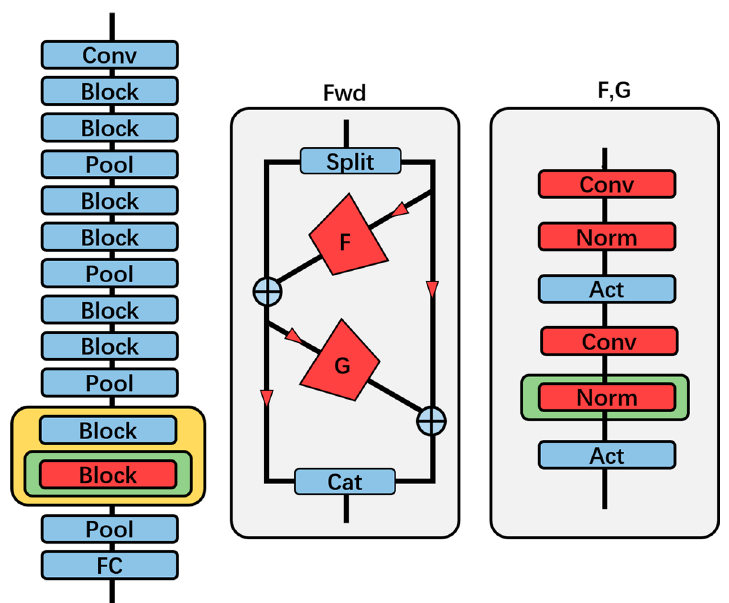
Fig. 4 Illustration of the i-Revnet architecture and its memory consumption. The peak memory consumption happens during the backward pass through the top reversible block. In addition to this local memory bottleneck, the cost of storing the top layers weights (in orange) becomes a new memory bottleneck as the weight kernel size grows quadratically in the number of